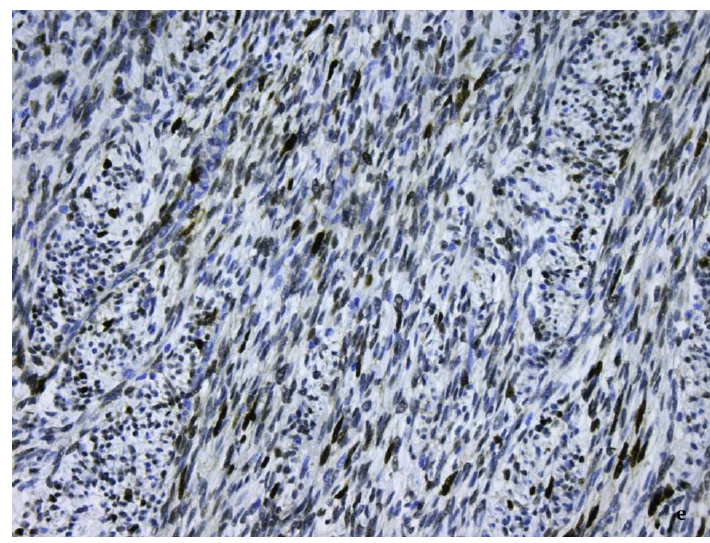
Figure 10. Intimal sarcoma. Note the intravascular location ( a ), and the heterogeneous outlook of the tumor, ranging from bland spindled ( b ), to pleomorphic ( c ), to osteosarcoma-like ( d ). MDM2 expression is seen in ( e ).